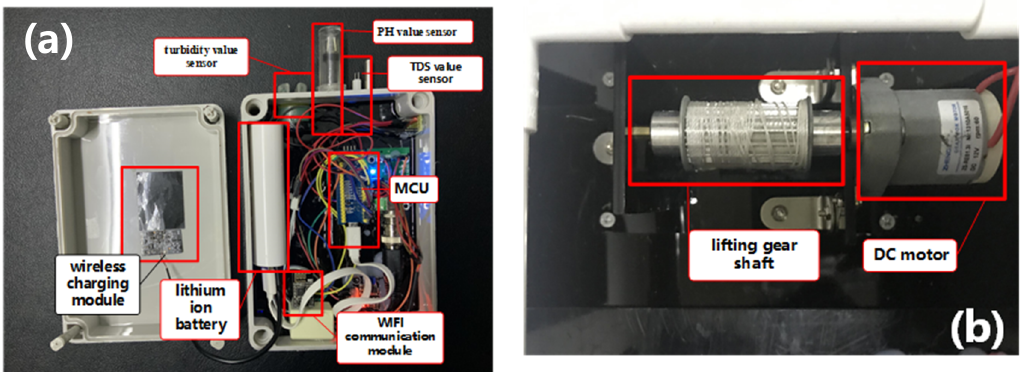
Figure 6. ( a ) Arrangement of sensors of water quality monitoring system (WQMM), ( b ) Lifting device.